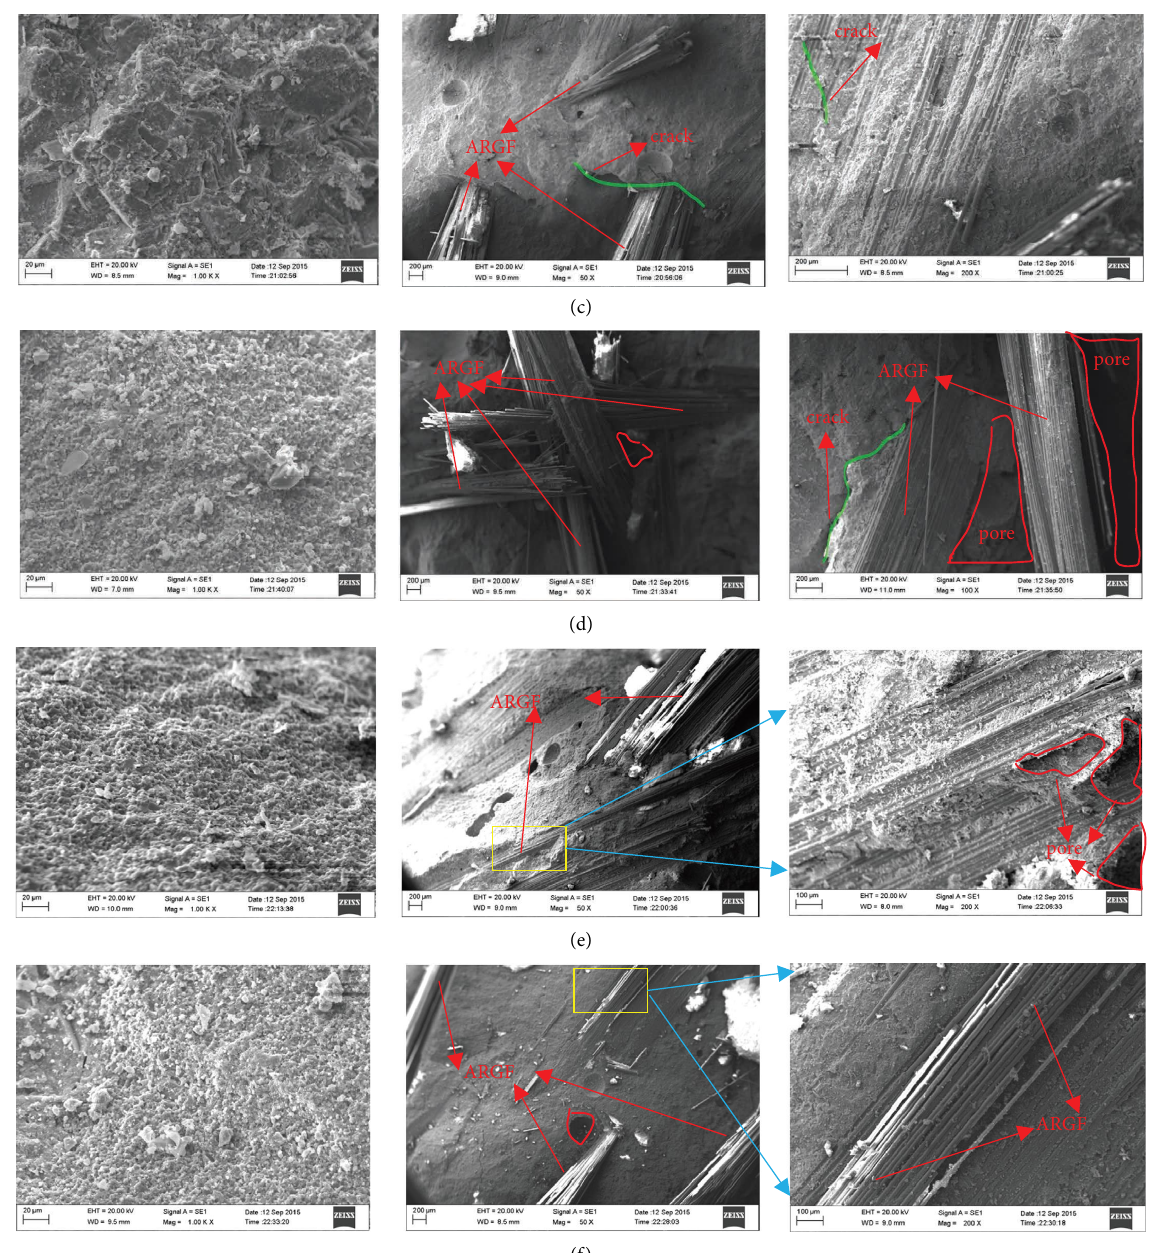
Figure 12: ARGFRC SEM observation: (a) SEM-FC0.3; (b) SEM-FC0.5; (c) SEM-FC0.8; (d) SEM-FC1.0; (e) SEM-FC1.3; and (f) SEM-